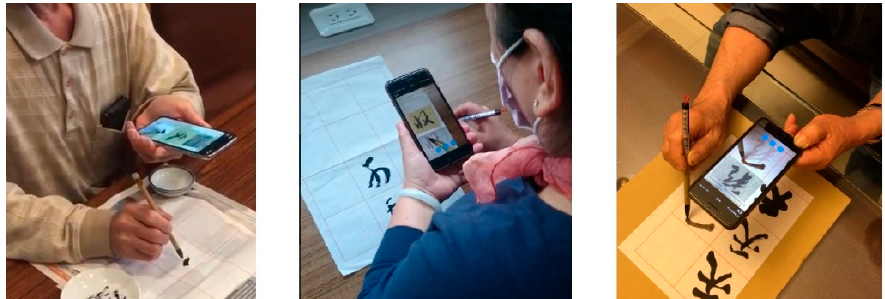
Figure 2. Schematics showing the operation of the calligraphy AR.